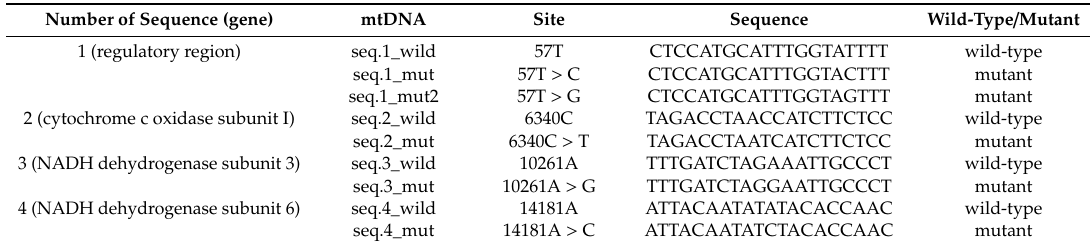
Table 1. Mitochondrial DNA sequences that were used in the study.